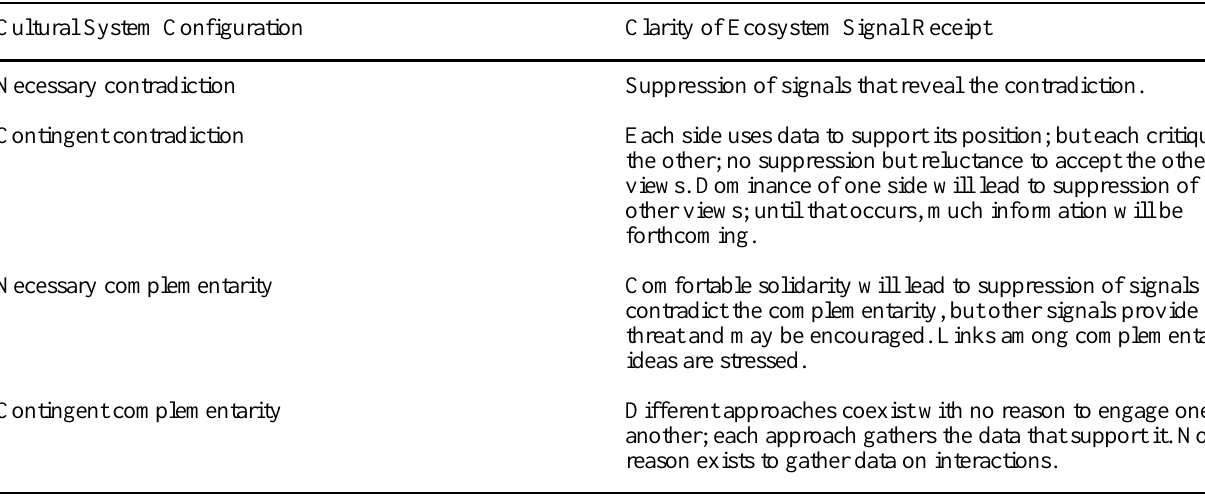
Table 1. Effects of cultural system configurations on ecosystem monitoring Cultural System Configuration Clarity of Ecosystem Signal Receipt Necessary contradiction Suppression of signals that reveal the